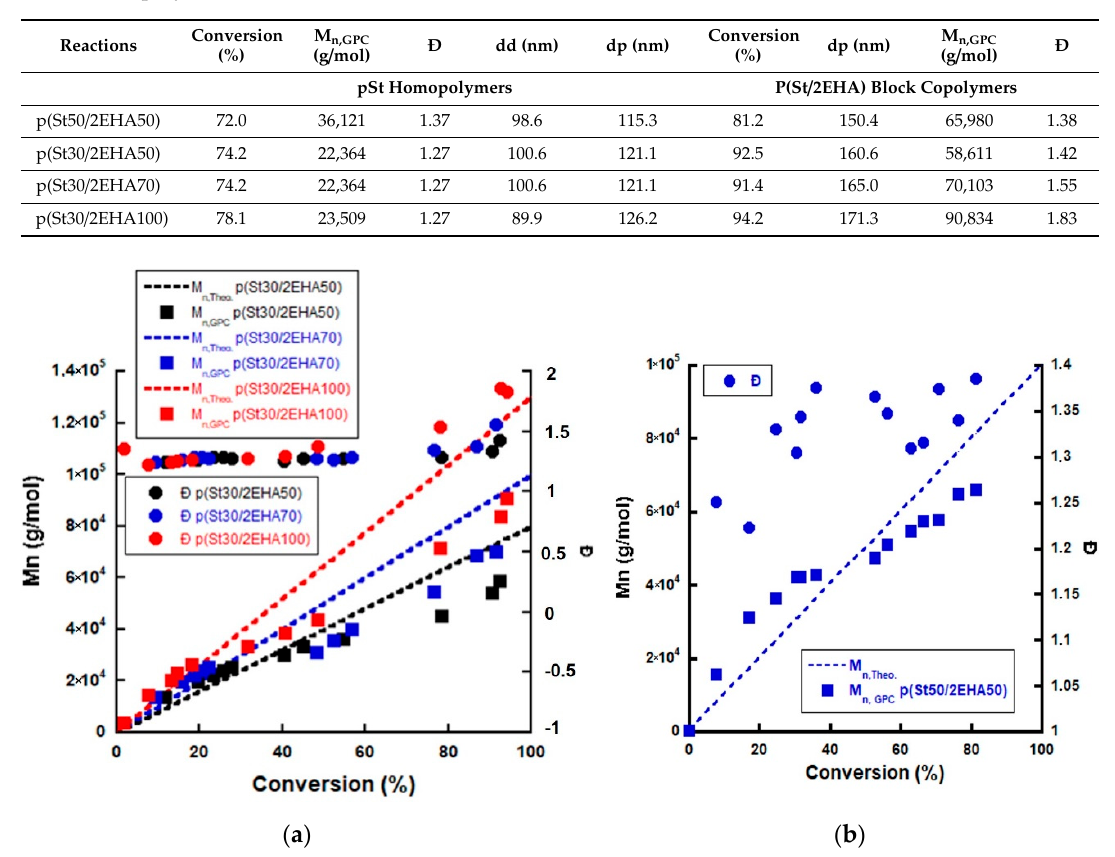
Figure 3. Evolution of the number average molecular weight and dispersity versus monomer conversion for ( a ) p(St30 / 2EHA50), pSt(30 / 2EHA70), and p(St30 / 2EHA100) and ( b ) p(St50 / 2EHA50) block copolymers.